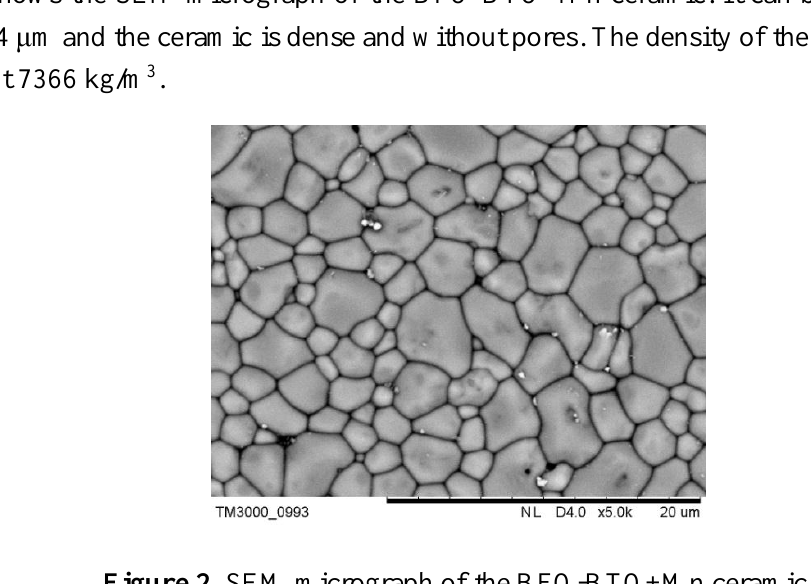
Figure 2. SEM micrograph of the BFO-BTO+Mn